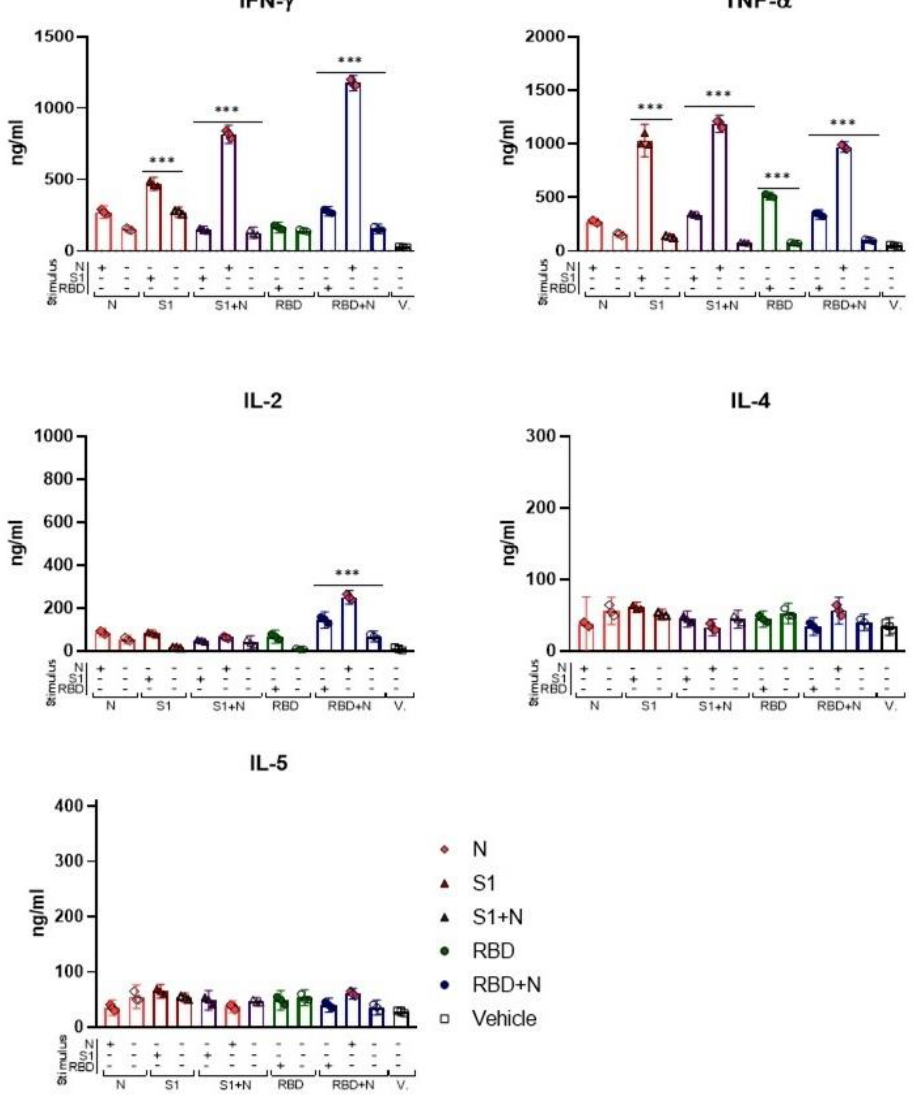
Figure 6. Immunization with recombinant proteins elicits a cellular response. Splenocytes from mice immunized with recombinant proteins alone or in combination were stimulated with 2 µ g/mL of N, S1, and RBD recombinant proteins. No stimulated cells were used as controls. After 48 h, the levels of IFN- γ , TNF- α , IL-2, IL-4, and IL-5 were determined using CBAs in the supernatants of these cells. Each point represents a pool of three mice, and each bar represents an average of a group of 3 mice. A nonparametric ANOVA test was used; bars represent the mean ± SD. * p < 0.05, ** p < 0.01, *** p < 0.001. p ≤ 0.05 was considered statistically significant. Prism v.8 software was used for statistical analyses (GraphPad Inc., La Jolla, CA,